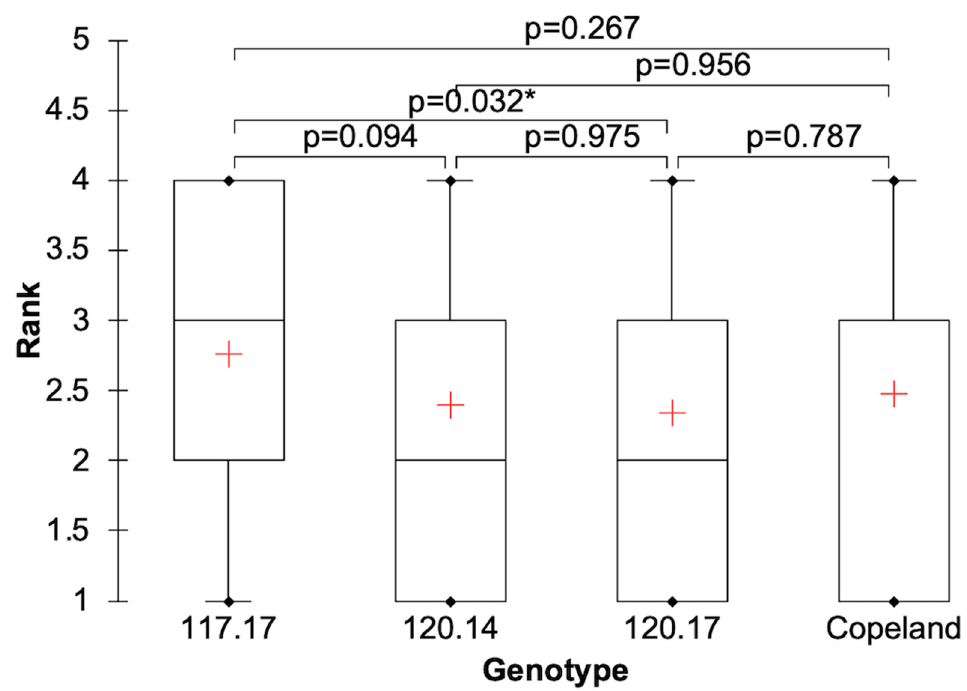
Figure 2. Boxplot representing rank data (1 = favorite, 4 = least favorite) for each genotype. One box plot per genotype is displayed. Red crosses correspond to mean values and central horizontal bars correspond to median values. Upper and lower limits of the box are the third and first quartiles, respectively. The box plot’s horizontal width has no statistical meaning. *: significant at level alpha = 0.05; note: Copeland median value is 3 .